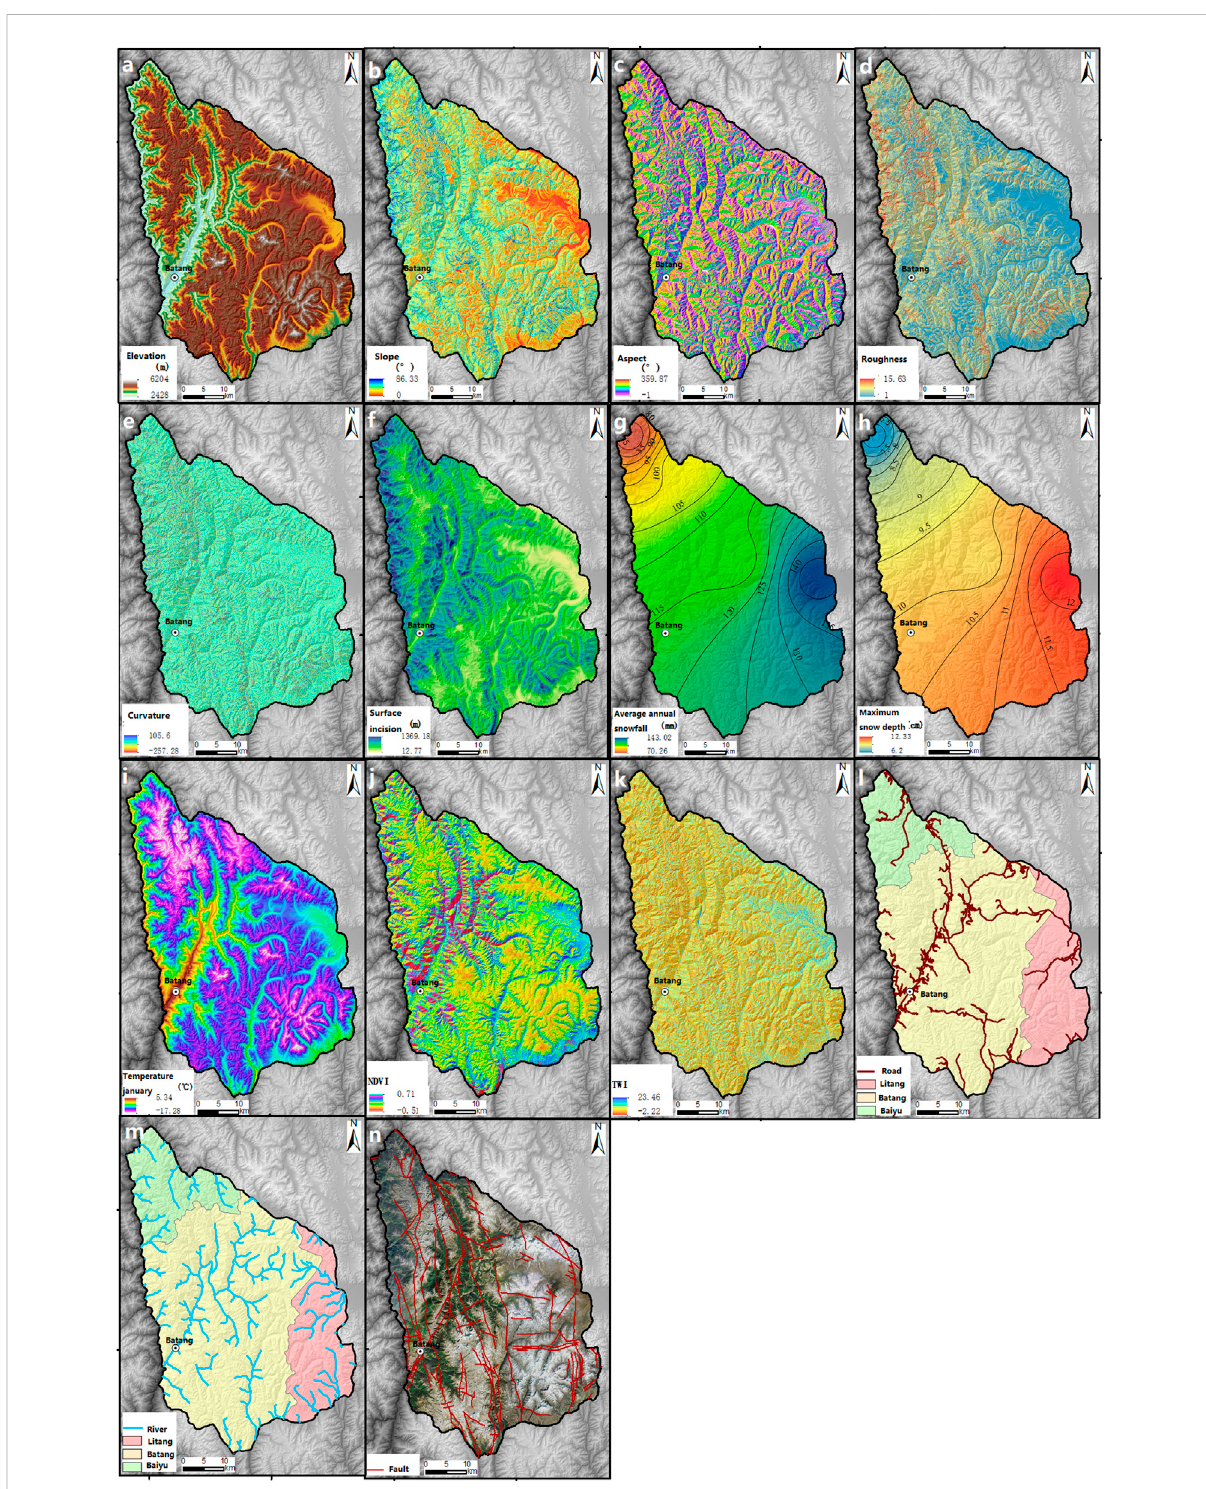
FIGURE 3 Snow avalanche conditioning factors, within the research area, Elevation (A) , Slope (B) , Aspect (C) , Roughness (D) , Curvature (E) , Surface (F) , Average annual snowfall (G) , Maximum snow depth (H) , Temperature (I) , NDVI (J) , TWI (K) , Road distance (L) , River distance (M) , Fault distance (N)